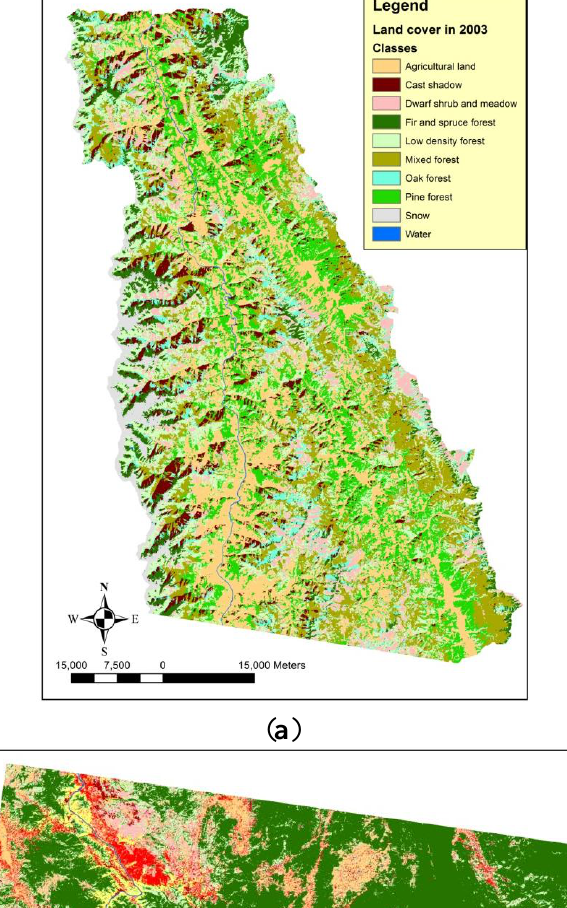
Figure 6. Land cover maps derived from ANN image classification incorporating the four CCA axes as extra channels in both study areas. ( a ) Land cover image classification in the northern study area; ( b ) Land cover image classification in the southern study